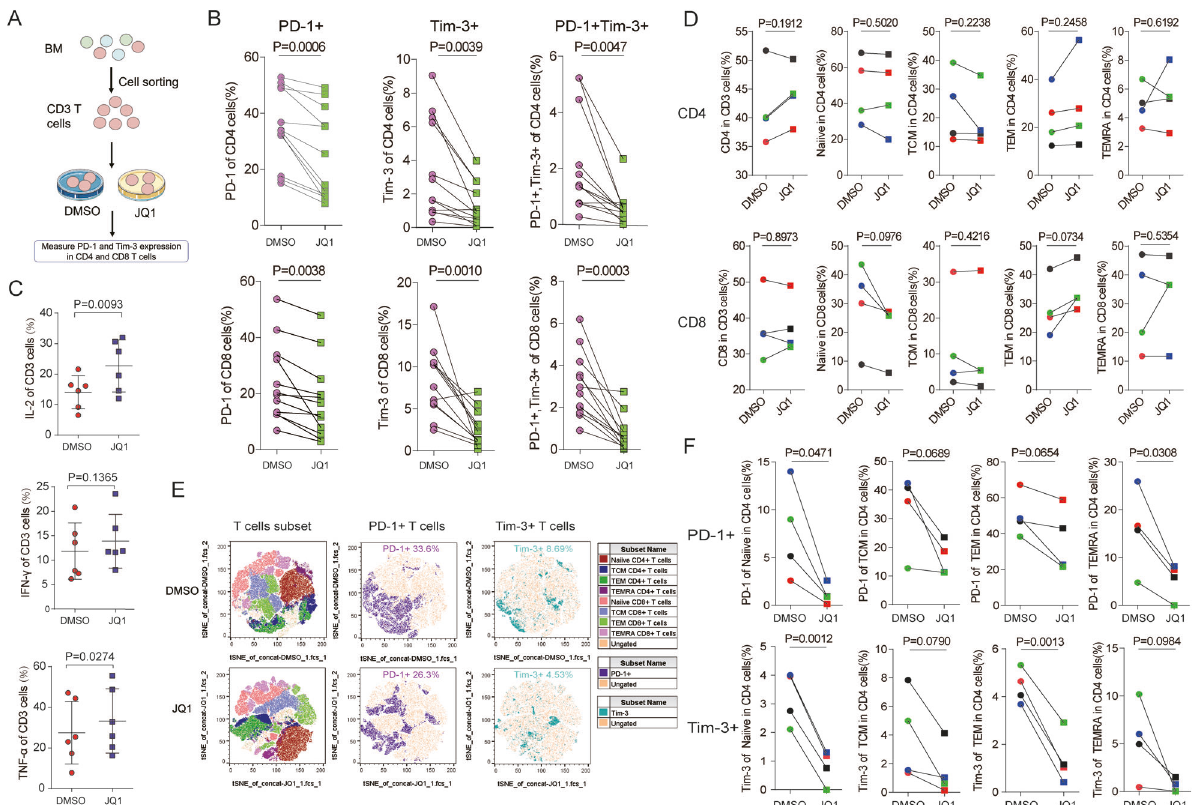
Fig. 4 BET inhibition reverses the exhausted phenotype of T cells from AML patients. A Flow diagram of the experimental design. B CD4 + T cells ( fi rst row) and CD8 + T cells (second row) from bone marrow (BM) of newly diagnosed AML patients were treated with 0.5 μ M JQ1 for 24 h, and the percentages of PD-1-positive ( fi rst column), Tim-3-positive (second column) and PD-1 and Tim-3 double-positive (third column) cells were determined by FACS. C CD3 + T cells from patients were treated with 0.5 μ M JQ1 for 24 h, and the percentages of IL-2, IFN- γ , and TNF- α from CD3 + T cells were evaluated by intracellular fl ow cytometry. D CD3 + T cells from AML patients ( n = 4 samples) were treated with 0.5 μ M JQ1 for 24 h, and the percentages of the CD4 + (upper), and CD8 + (lower) subpopulations were shown with differences in the phenotypic distribution of naive (CCR7 + CD45RA + , second column), TCM (CCR7 + CD45RA − , third column), TEM (CCR7 − CD45RA − , fourth column), and TEMRA (CCR7 − CD45RA + , right) T-cell subsets. E © Concatenated fi les representing AML samples in the DMSO group (upper) and JQ1 (lower) groups projected in tSEN plots after gating on lymphocyte cells. Distribution of naive, TCM, TEM, and TEMRA CD4 + T cells were shown as dark red, dark yellow, dark green, and dark purple, respectively, and the distribution of naive, TCM, TEM, and TEMRA CD8 + T cells were shown as light red, light yellow, light green, and light purple, respectively. F CD3 + T cells from AML patients ( n = 4 samples) were treated with 0.5 μ M JQ1 for 24 h, and the percentages of PD-1 positive (upper row) and Tim-3 positive (lower row) cells in naive (left), TCM (second column), TEM (third column), and TEMRA (right) CD4 + T cells were determined by FACS. Data are expressed as mean ± SD. P value < 0.05 was considered to be signi fi cant (two-tailed paired Student ’ s t